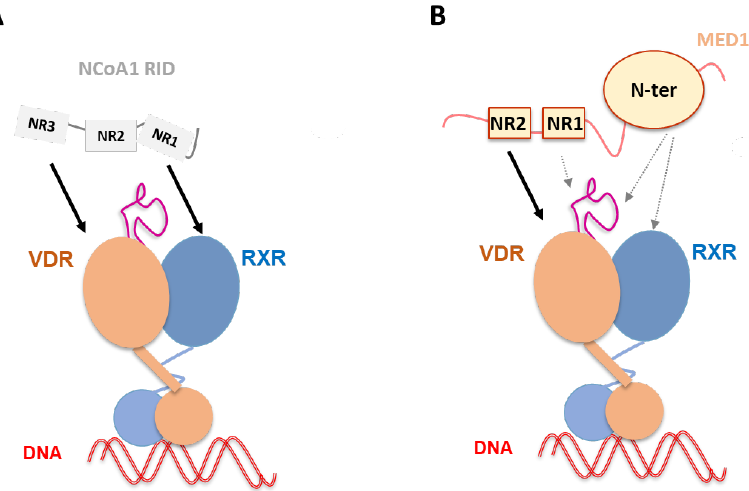
Figure 5. Schematic representation of NCoA1 and MED1 binding to liganded VDR–RXR–DNA complex. ( A ) NCoA1 RID binding to liganded VDR–RXR in complex with and without DNA [60]. The NCoA1 NR3 motif is associated to VDR and the NR1 to RXR. NCoA1 RID binding has been shown